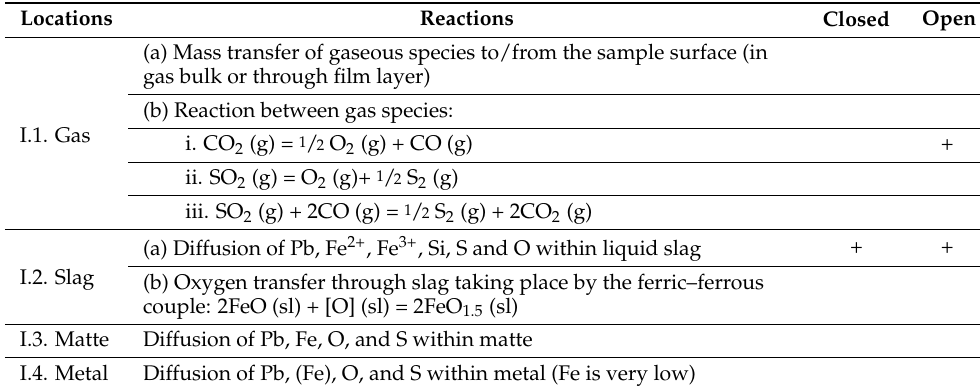
Figure 3. Schematic of possible interactions of components between the gas, slag, matte, metal, and tridymite phases in the Pb-Fe-O-S-Si system, including: I. Single, II. Two-, III. Three-, and IV. Four-phase interactions. Details of the reactions are given in Table 2. Table 2. Summary of selected elementary reactions and reaction steps taking place in the Pb-Fe-O-S-Si system for I. Single, II, Two-, III, Three-, and IV Four-phase interactions (indications of the most important reactions for the closed and open systems are given in the marked columns). Note: g = gas ; sl = slag; mat = matte ; met = metal.